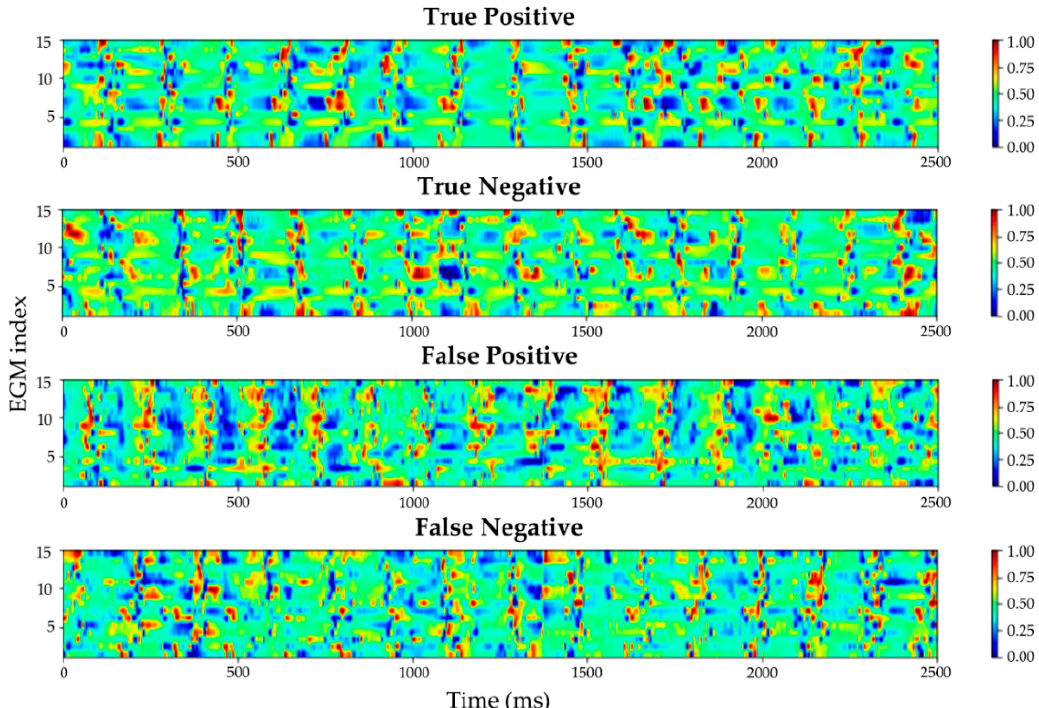
Figure 3. CRNN classification example. From top to bottom: the first signal shows a true positive example that exhibits a rotational activity in the last third of the temporal axis; the second signal shows a true negative classification (no rotor); the third signal shows a false positive; the fourth signal shows a false negative example of a missed rotor detection. CRNN, convolutional recurrent neural network; EGM, electrogram.